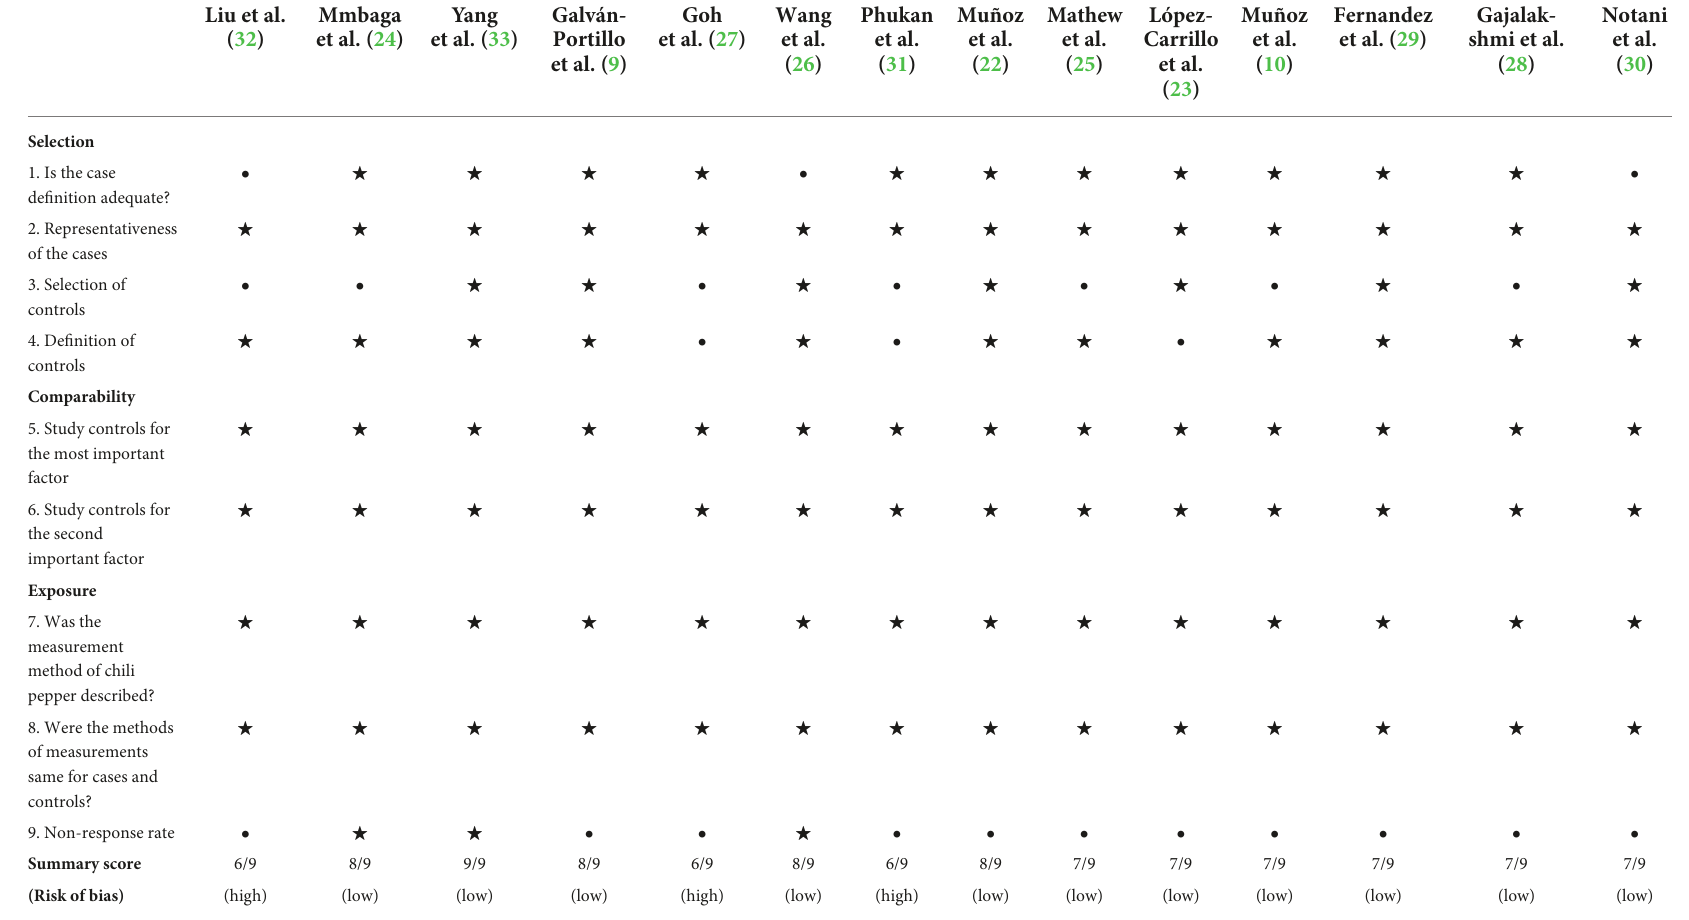
(high) (low) (low) (low) (high) (low) (high) (low) (low) (low) (low) (low) (low) (low) (cid:70) wasawardedwhentherespectiveinformationwasavailable. •